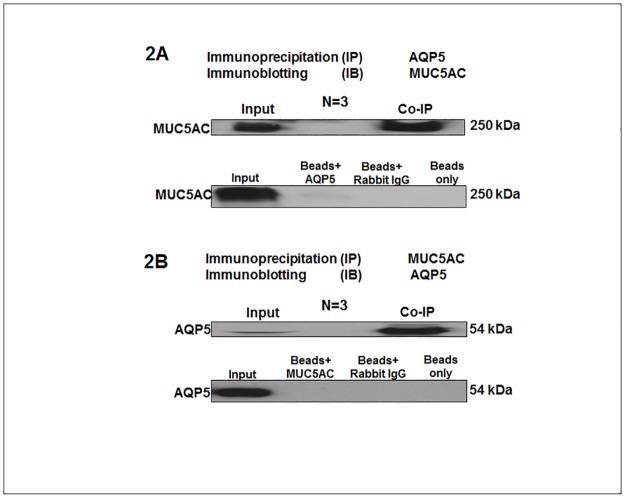
Co-immunoprecipitation (CoIP) of AQP5 and MUC5AC.(2A) The detection of MUC5AC in Ab-Ag complex by immunoprecipitation of AQP5 from rabbit conjunctival tissue protein lysate with AQP5 antibody bound to Dynabead® Magnetic beads coupled Protein A. Input: The normal rabbit conjunctival tissue protein lysate (Positive control for MUC5AC); Co-IP: MUC5AC protein signal detected in the Co-IP Ab-Ag complex by AQP5 antibody; Negative controls: Beads+AQP5 (magnetic beads incubated with only the AQP5 antibody); Beads + rabbit IgG (magnetic beads incubated with only the IgG antibody); Beads only (magnetic beads alone incubated in the reaction buffer). (2B) The CoIP of AQP5 by immunoprecipitation of MUC5AC from rabbit conjunctival tissue protein lysate with MUC5AC antibody bound to Dynabead® Magnetic beads coupled Protein A. Input: The normal rabbit conjunctival tissue protein lysate (Positive control for AQP5); Co-IP: AQP5 protein signal detected in the Co-IP Ab-Ag complex by MUC5AC antibody; Negative controls: Beads+ MUC5AC: Beads + rabbit IgG; Beads only.